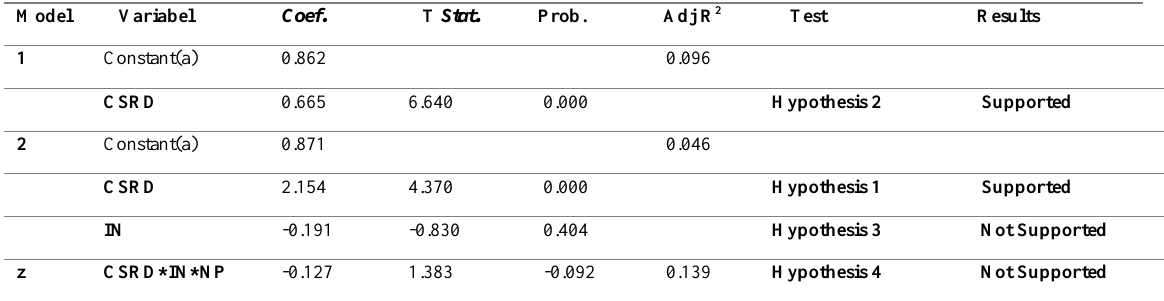
Table 3: Results of Regression